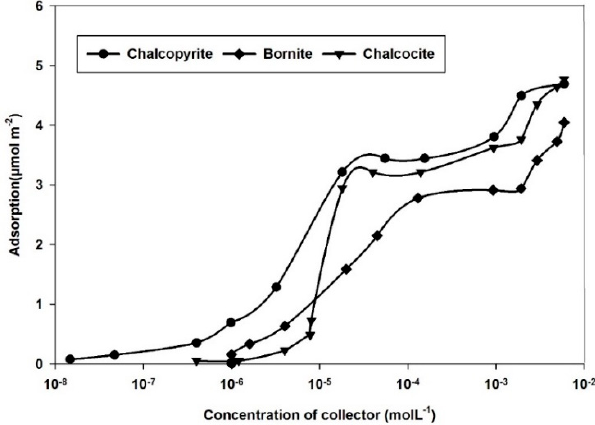
Figure 10. The adsorption of dithiophosphate on the copper sulphide surface at pH 8.